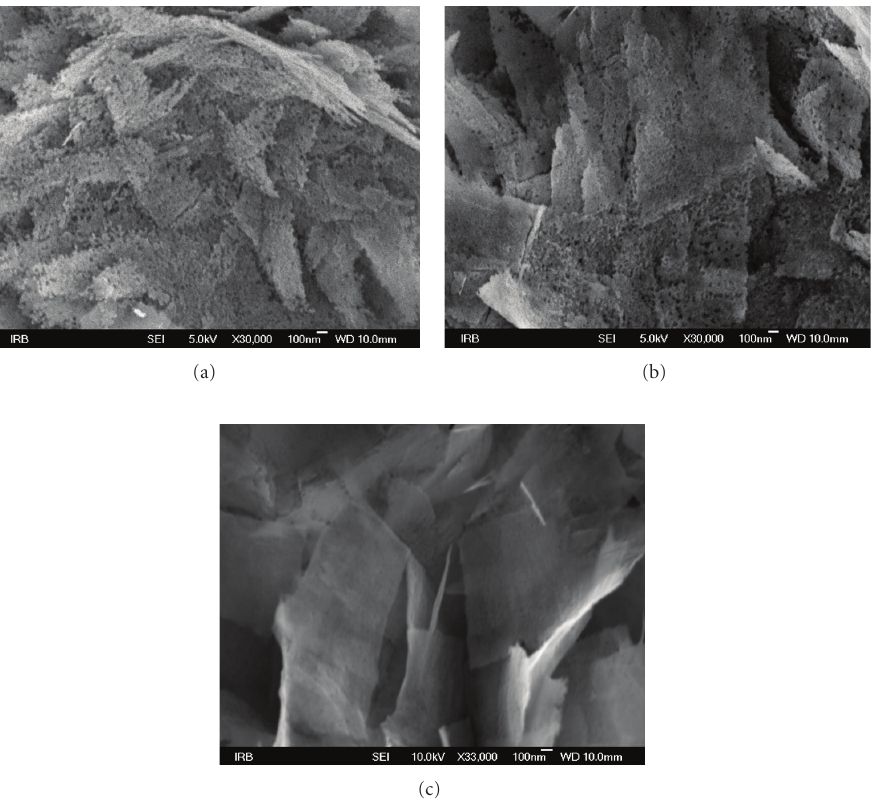
Figure 3: FE-SEM pictures—nanoscopic view—of sample A (a), sample B (b), and sample C